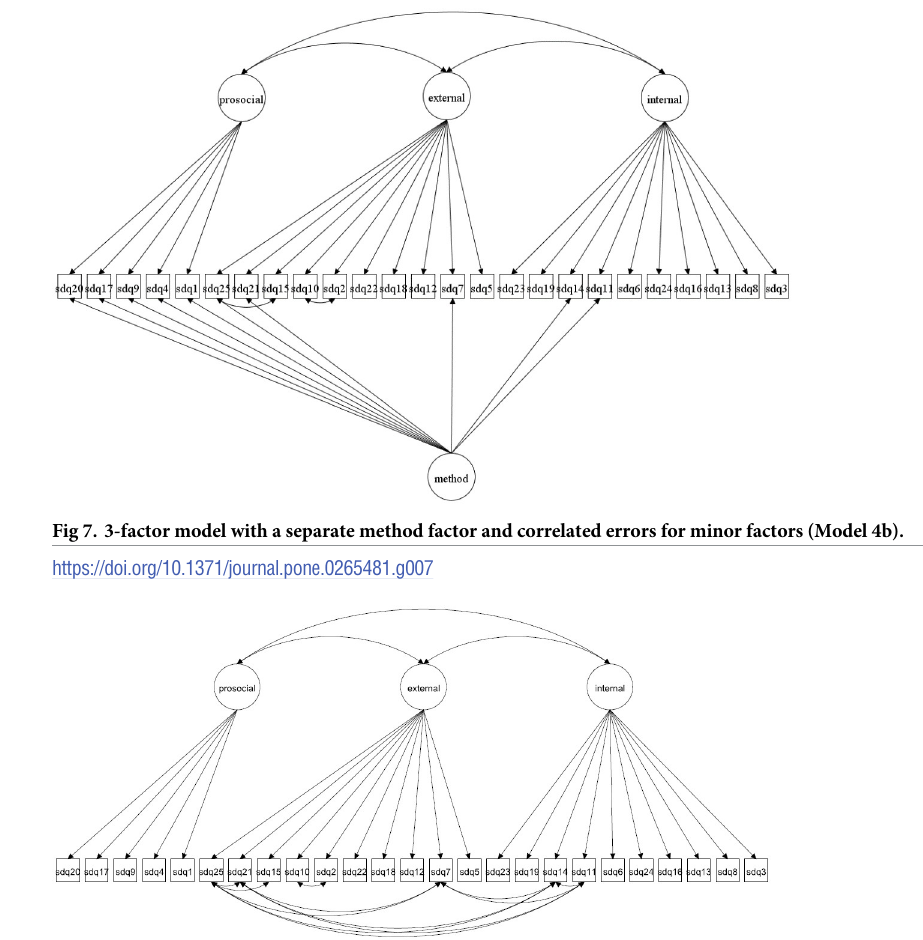
Fig 8. 3-factor model with correlated error terms for method effects and minor factors (Model 4c).